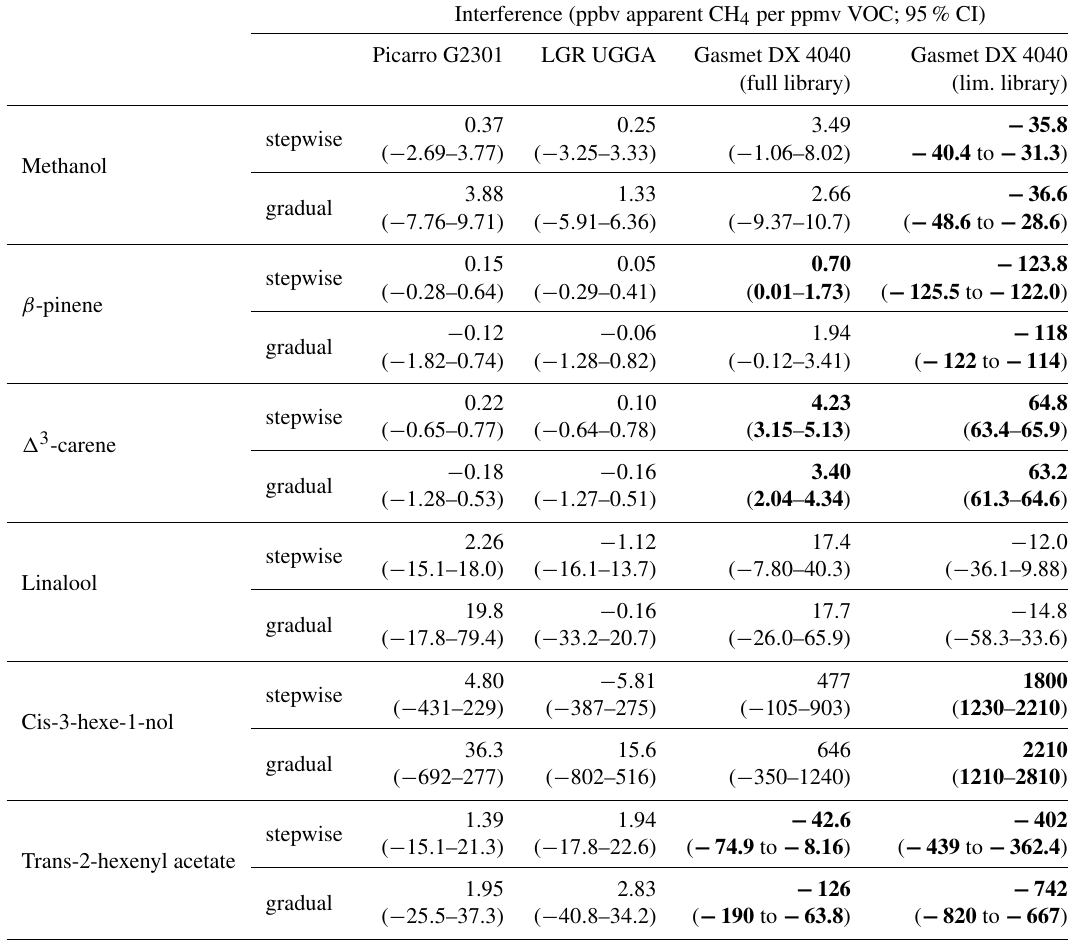
Table 3. Quantified interferences of volatile organic compounds on CH 4 analysers. Significant interferences are indicated in